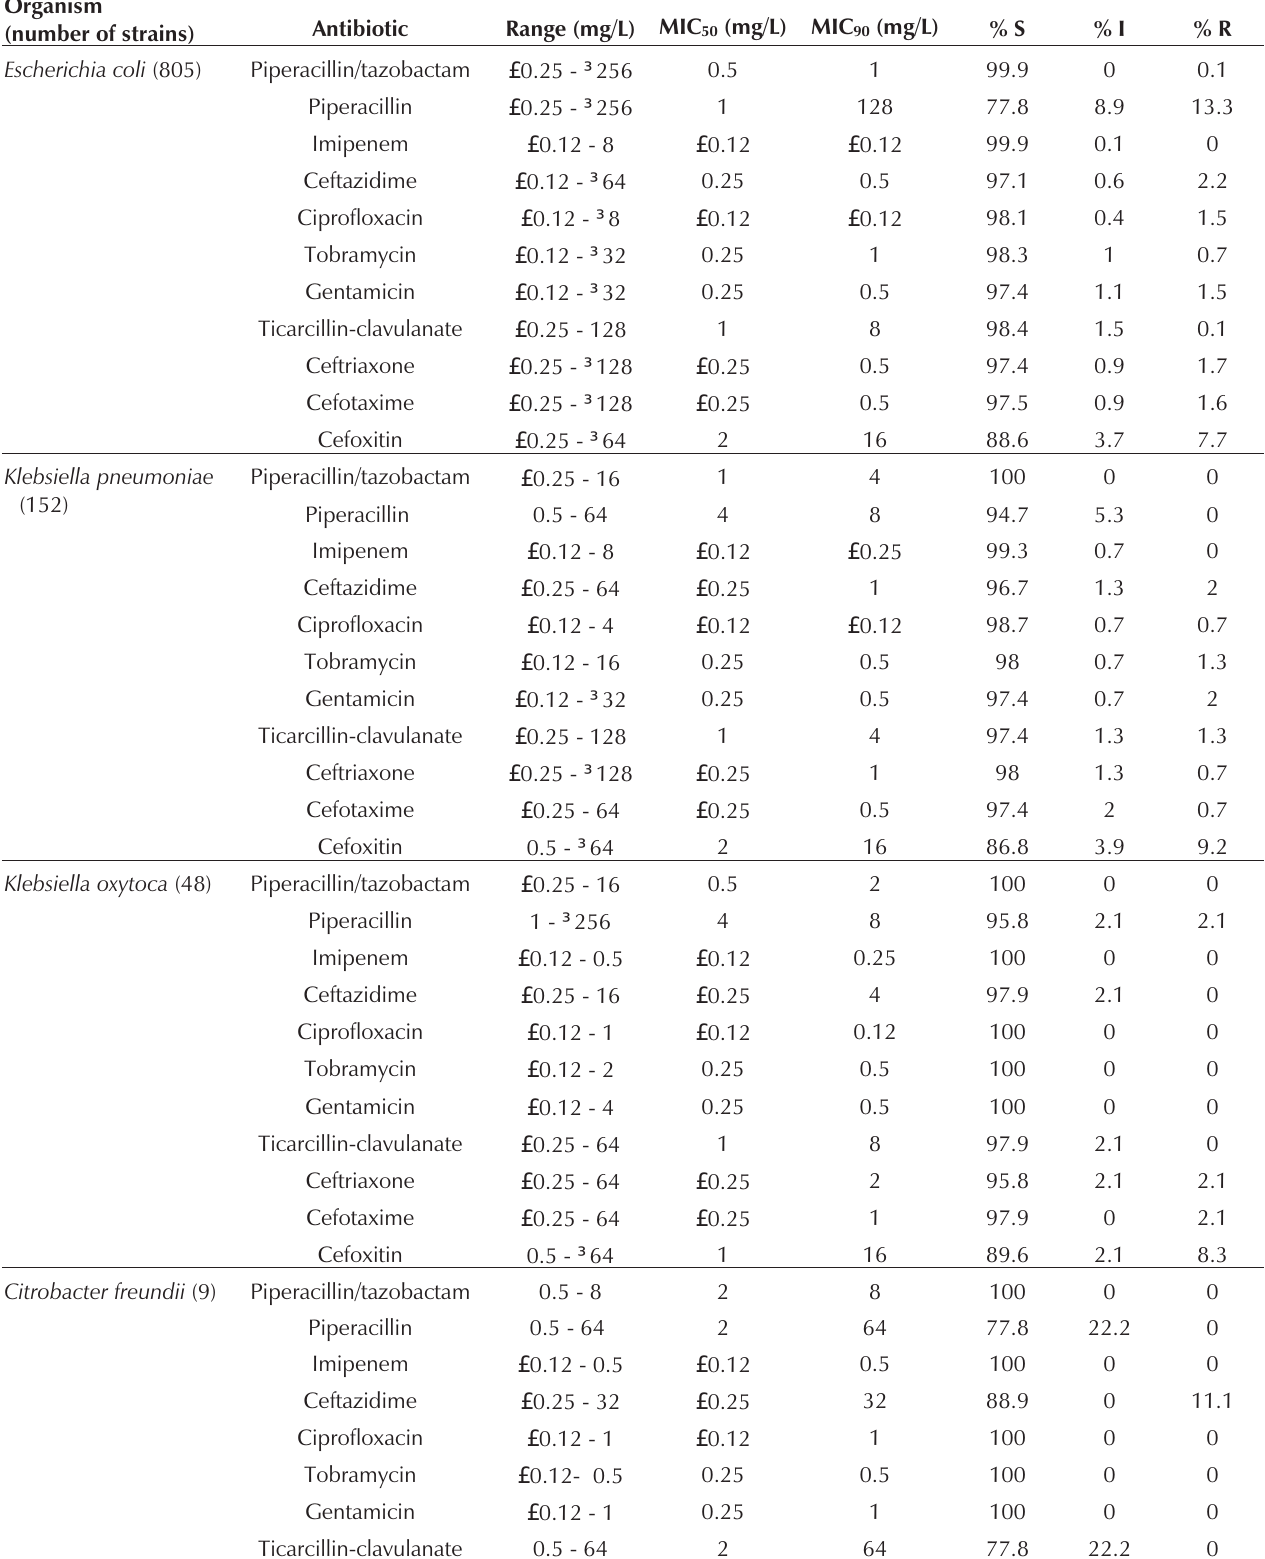
TABLE 2 Comparative activity of piperacillin/tazobactam and other antibiotics against 2747 aerobic blood culture isolates Organism (number of strains)